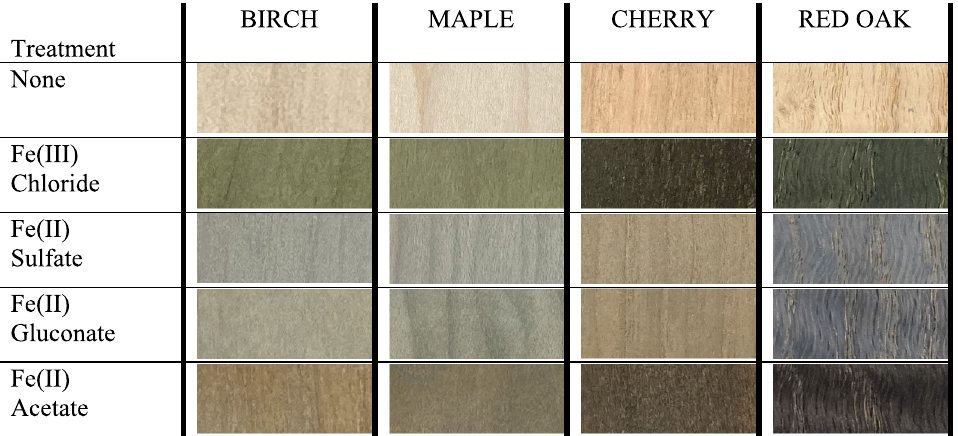
Fig. 1 Birch ( Betula alleghaniensis ), maple ( Acer saccharum ), cherry ( Prunus serotina ), and red oak ( Quercus rubra ) veneers treated with iron solutions. The iron–tannin reaction produces a variety of colors in the ebonized wood: light green (chloride with birch and maple); light gray (sulfate and gluconate with birch and maple); light brown (acetate with birch and maple, and sulfate and gluconate with cherry); dark gray (sulfate and gluconate with red oak); dark brown to black (chloride and acetate with cherry and red oak). Veneers were photographed 1 week after